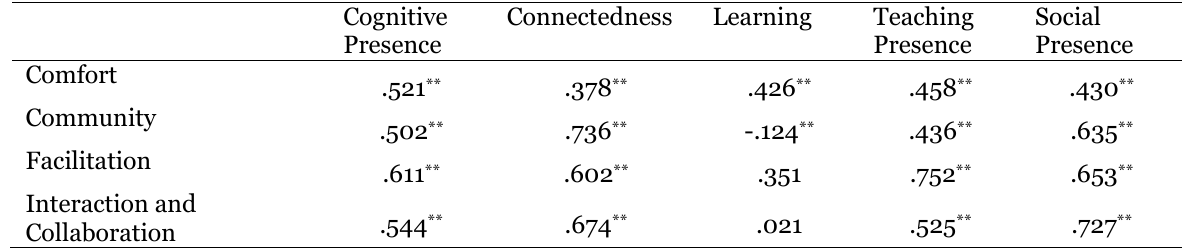
Correlations between Factors in the OSCS, COI, and CCS